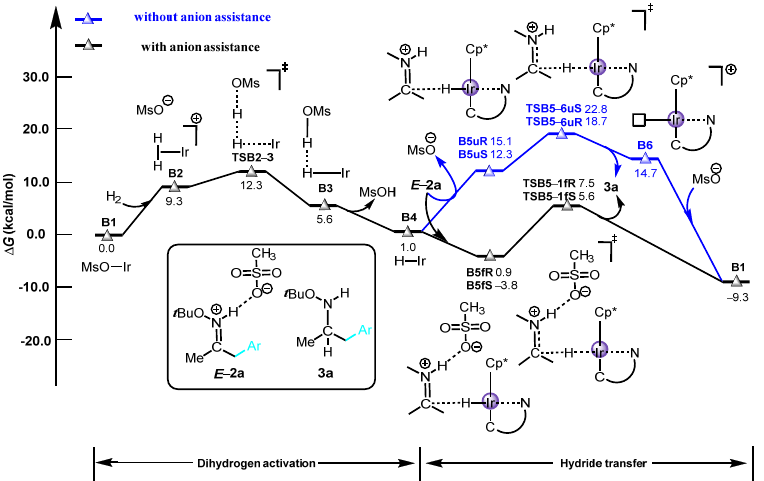
Figure 2. The Gibbs free energy profiles of asymmetric hydrogenation of oximes to hydroxylamines catalyzed by Ir complex B1 (unit: kcal/mol). * represents chirality and ‡ means this is a transition state.